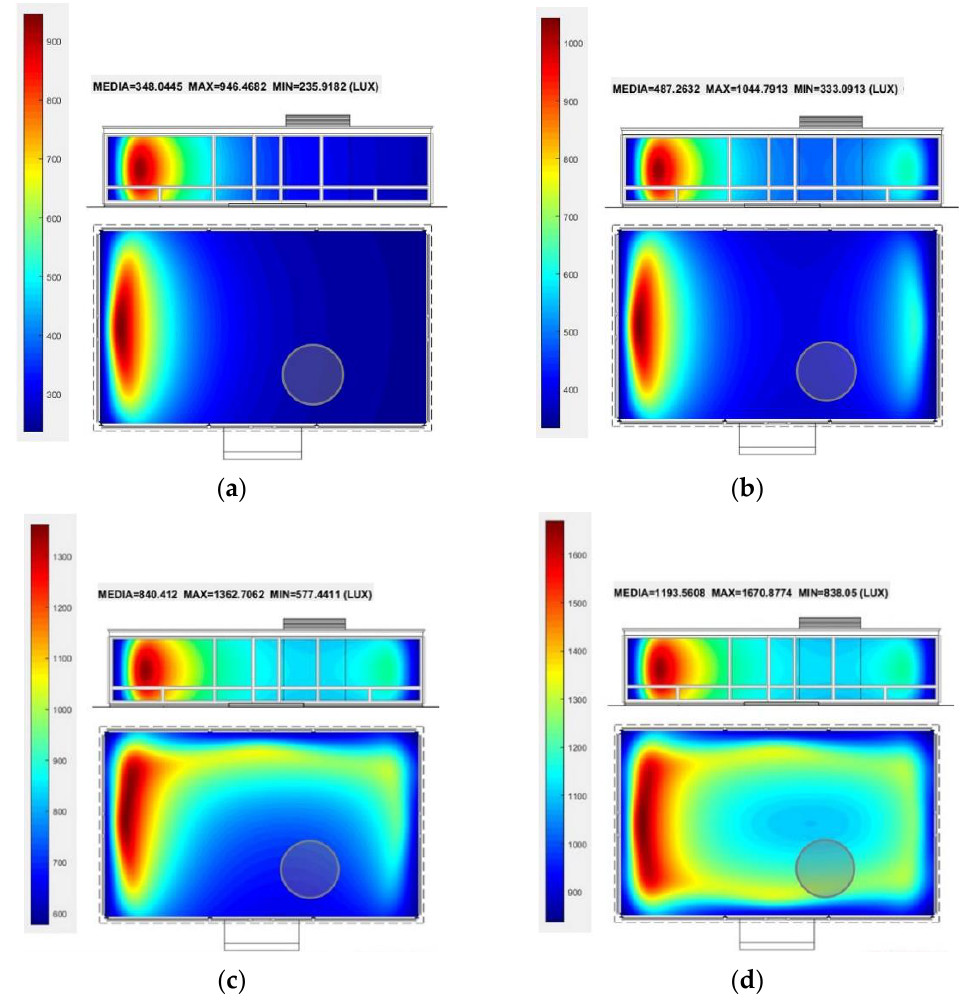
Figure 13. Lighting breakdown following the four façades of the building. ( a ) Glazing only on the left side. ( b ) Left and right sides. ( c ) Both sides and glazing on the upper side. ( d ) Glazing on the four sides.